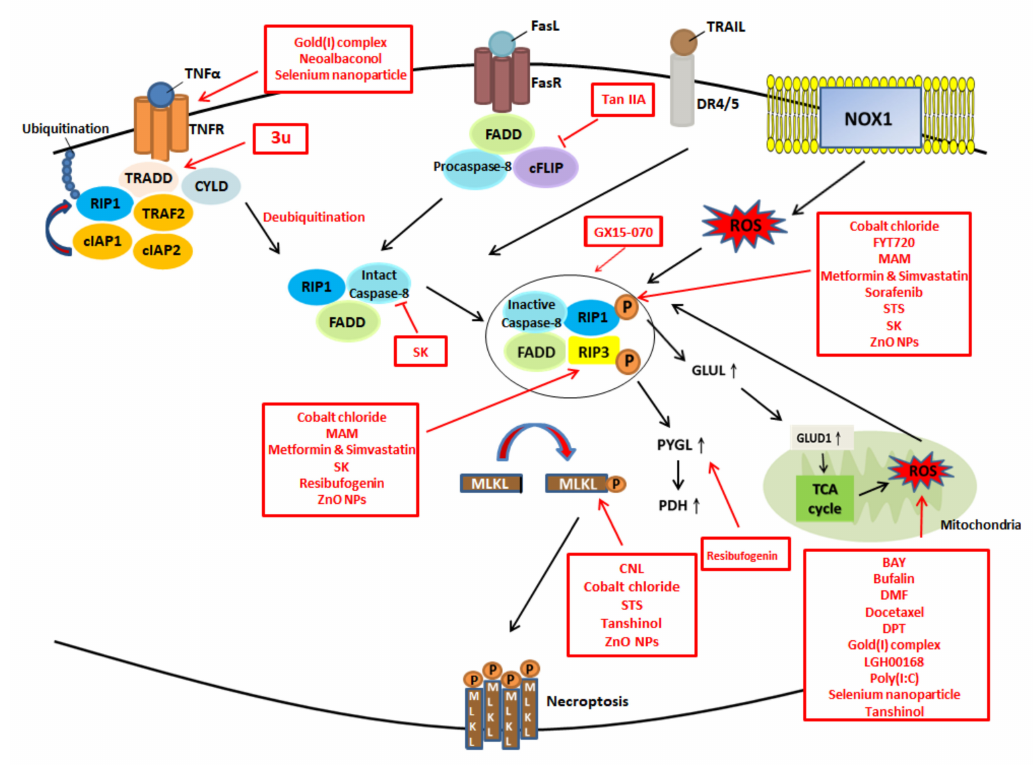
Figure 4. The potential drugs and their targets in modulation of necroptosis and